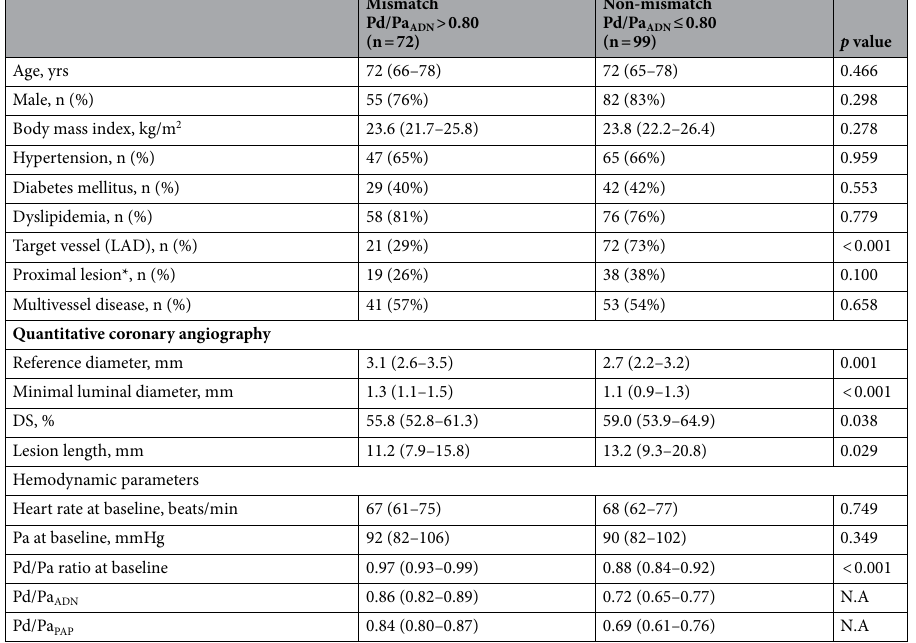
Table 2. Comparion clinical and lesion characteristics in vessels with DS > 50% between the anatomical– functional mismatch and non-mismatch groups. Values are expressed as medians (interquartile ranges) or frequencies (percentages). The mismatch was defined as DS > 50% and Pd/Pa ADN > 0.80, and the non-mismatch as DS > 50% and Pd/Pa ADN ≤ 0.80. *Proximal location was defined as Syntax segments 1, 5, 6, and 11. DS diameter stenosis, LAD left anterior descending coronary artery, Pa aortic pressure, Pd/Pa distal-to-aortic pressure ratio, Pd/Pa ADN distal-to-aortic pressure ratio associated with adenosine, Pd/Pa ADN distal-to-aortic pressure ratio associated with